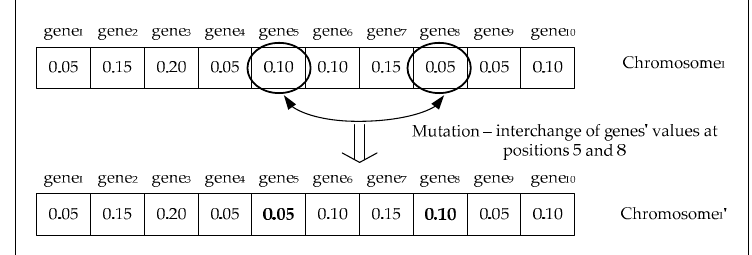
Figure 8. The example of the mutation genetic operator.